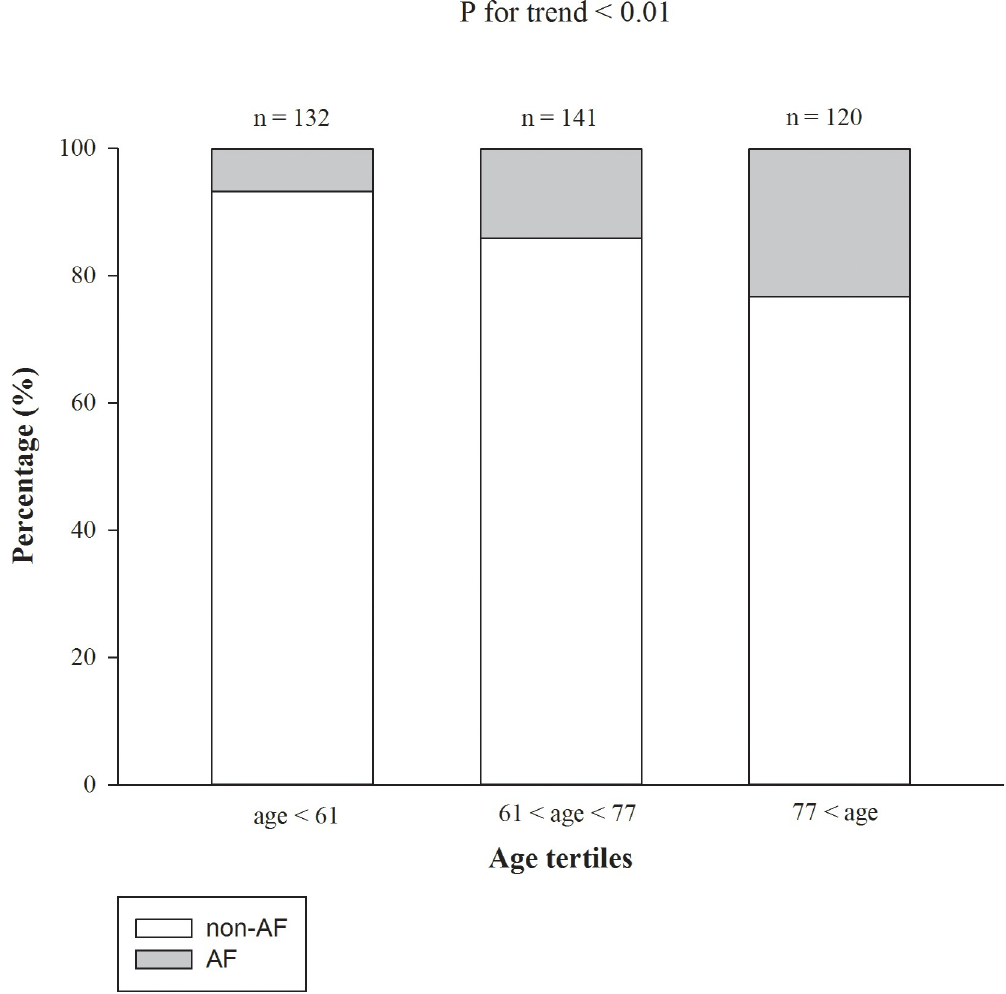
Fig 2. HR of AF for mortality of incident hemodialysis patients stratified by age. Multivariate model was adjusted for presence of heart failure, chronic obstructive pulmonary disease, serum levels of albumin and phosphorus. HR, hazard ratio; CI, confidence interval; AF, atrial